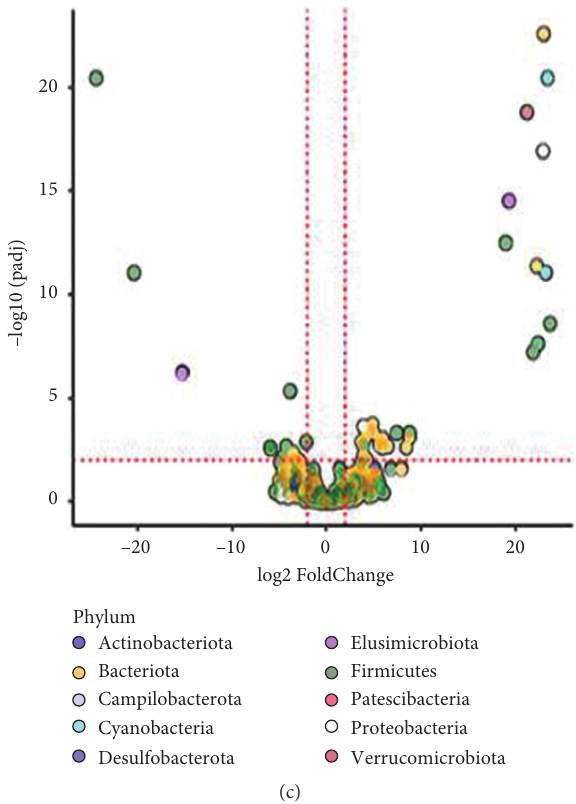
Figure 2: Gut microbial differences between populations. (a) Species richness and Shannon’s diversity varied slightly between the three populations ( P � 0 . 007453 and 0.017, respectively, Kruskal–Wallis test). Species richness was significantly different between Kamalabari (KB) and Jagiroad. Shannon’s differed significantly in Kamalabari population relative to the other two populations. (b) Visualization of PCoA using Bray–Curtis distance revealed that Kamalabari was significantly different from both the Nepali populations. Aanthmile (AM) and Jagiroad (JR) populations did not differ significantly. (c) A total of 44 amplicon sequence variant (ASV) level differences between the populations (compared to Kamalabari) were obtained using differential expression analysis for sequence count data version 2 (DESeq2) ( ∗∗ < 0 .